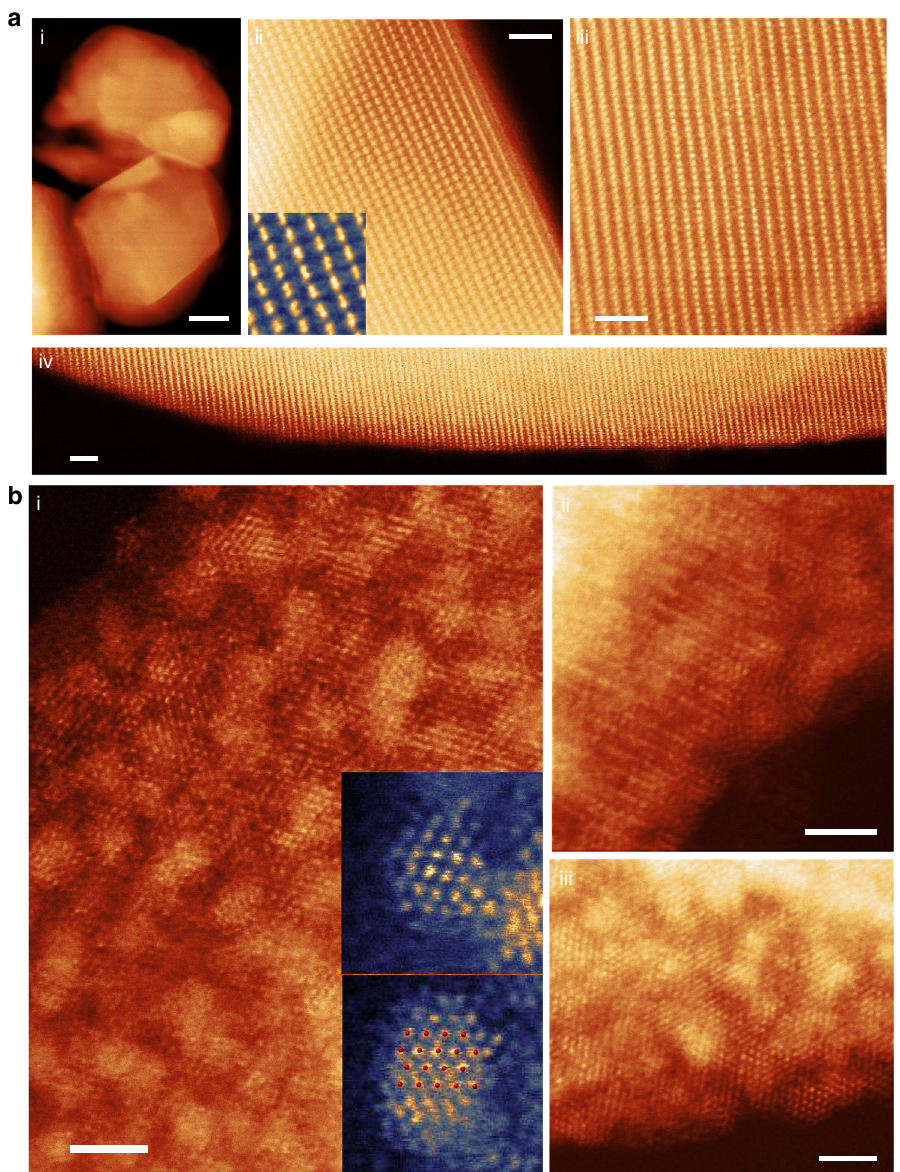
Fig. 3 Atomic-scale imaging of the near-surface structure of primary particles. Aberration-corrected high-angle annular dark- fi eld scanning transmission electron microscopy (Z-contrast STEM) image of a pristine LRMO and b LRMO after 15 cycles. a Atomic-resolution Z-contrast images show dark lithium diffusion channels extend from the interior of the particle to the surface indicating that the structure at the surface is nearly the same as the bulk. b Images show the near-surface area of LRMO was signi fi cantly disrupted after 15 charge/discharge cycles. High-intensity clusters are observed over the entire surface. Insets of b (i) show atomic-resolution images of the segregated clusters agree with the projected structure of metallic ruthenium (atomic structure overlaid in red). (Scale bar in a (i) 100 nm; scale bar in the rest: 2